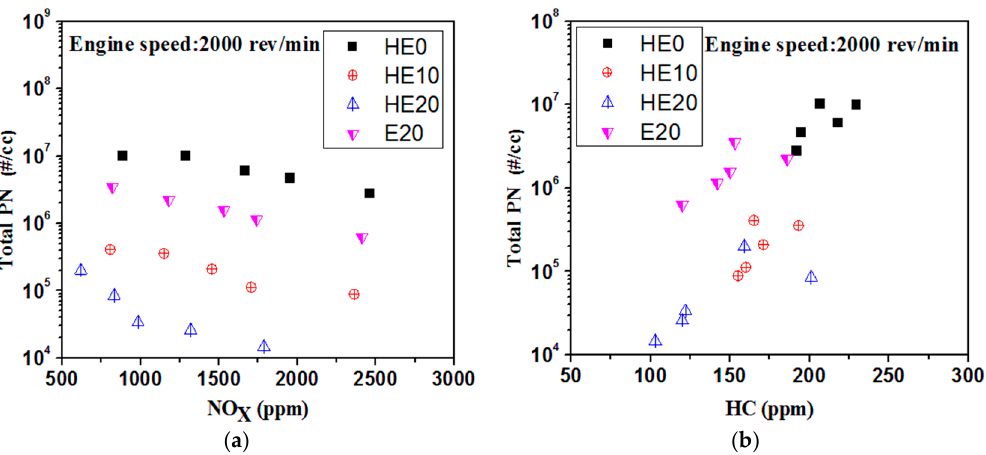
Figure 12. Correlation between total PN and ( a ) NO x emission; ( b ) HC emission.